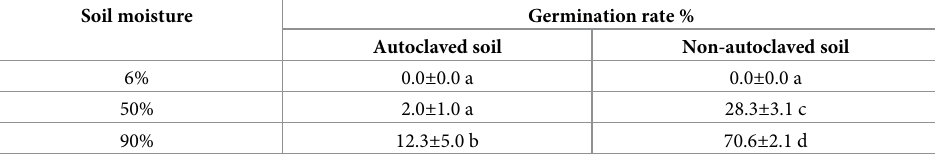
Table 2. Germination rates of P . brassicae resting spores incubated in autoclaved and non-autoclaved soil with different levels of moisture.